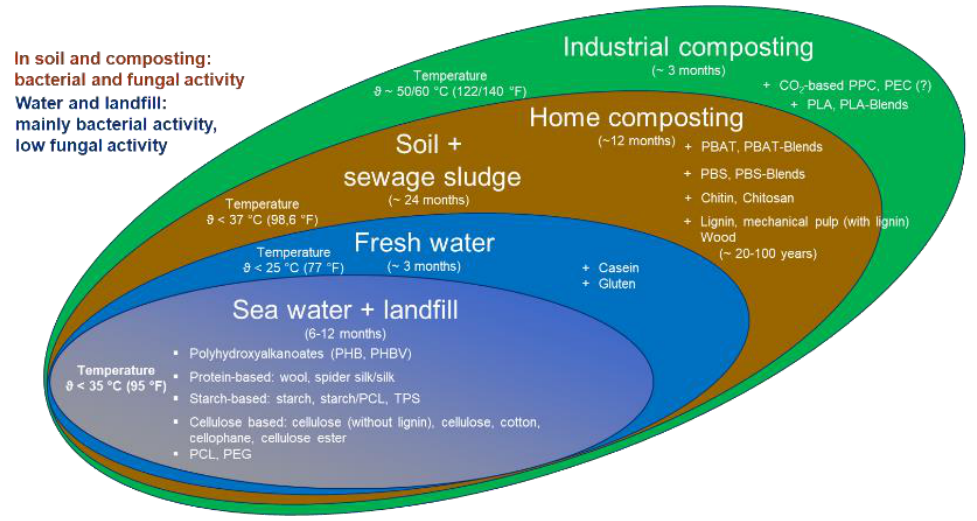
Figure 2. Biological degradation of different polymers in different environments.